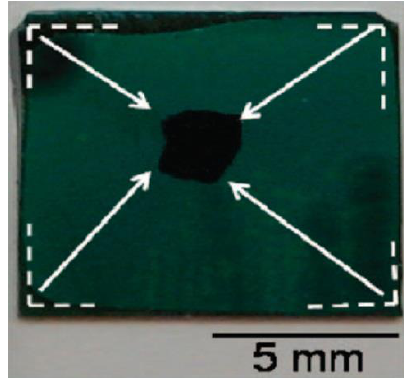
Figure 5. Photograph of a dense CNT membrane after n-hexane evaporation, white dotted lines indicate the original size of as-grown CNT forest (Yu et al.,